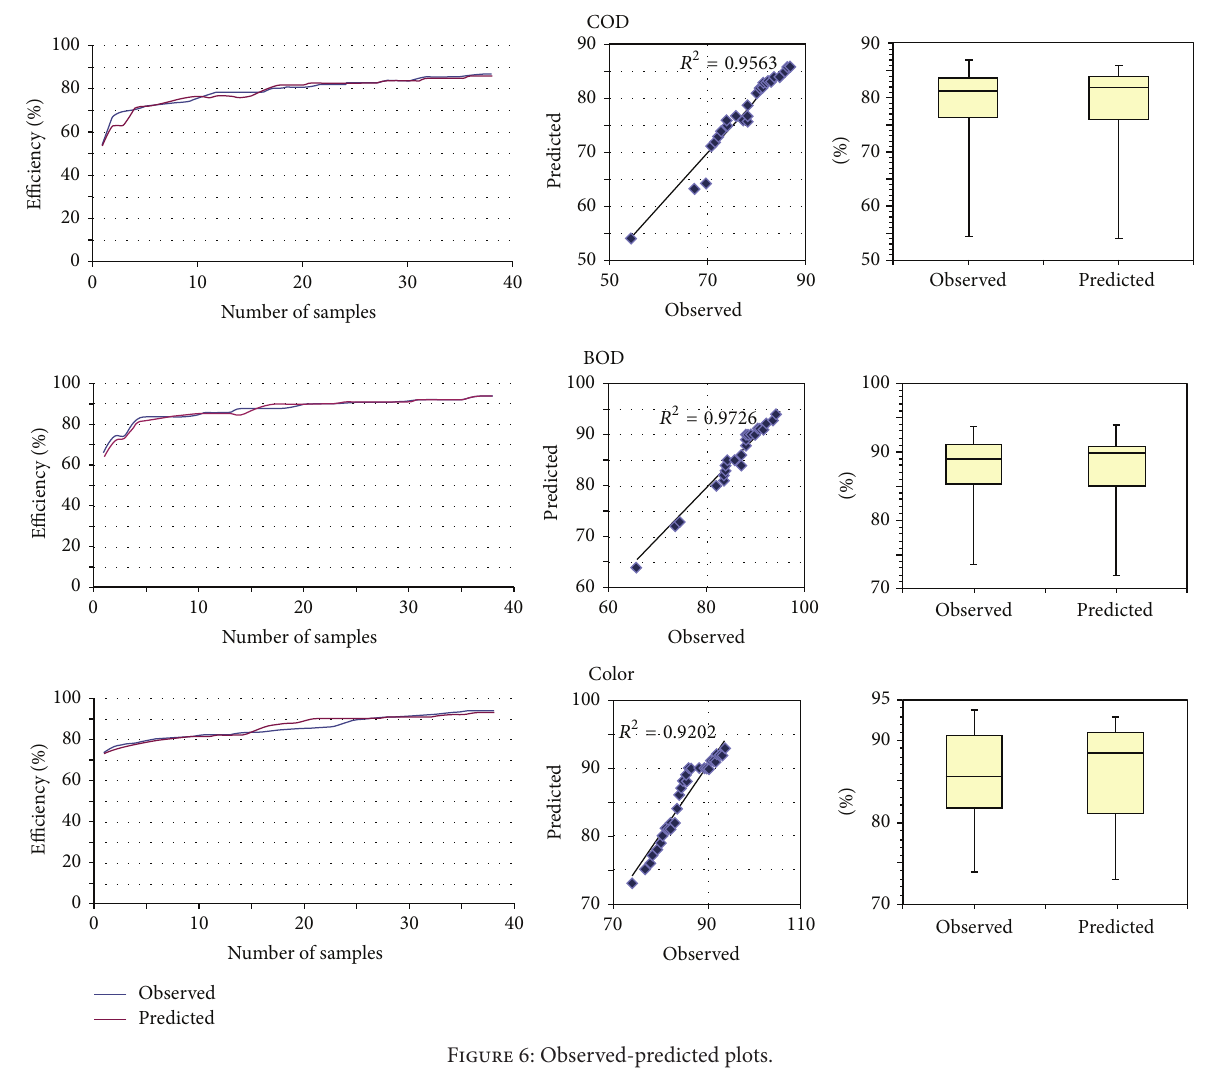
Figure 6: Observed-predicted plots.